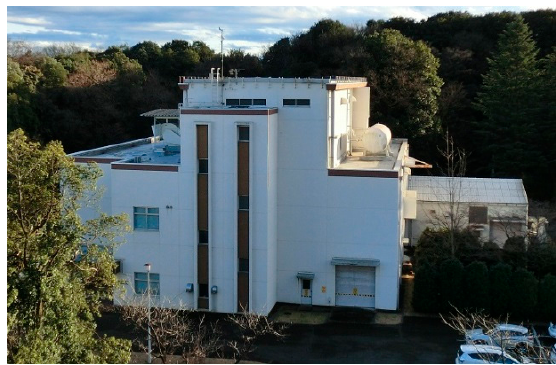
Figure 4. A picture of the building of the electron beam irradiation facility.